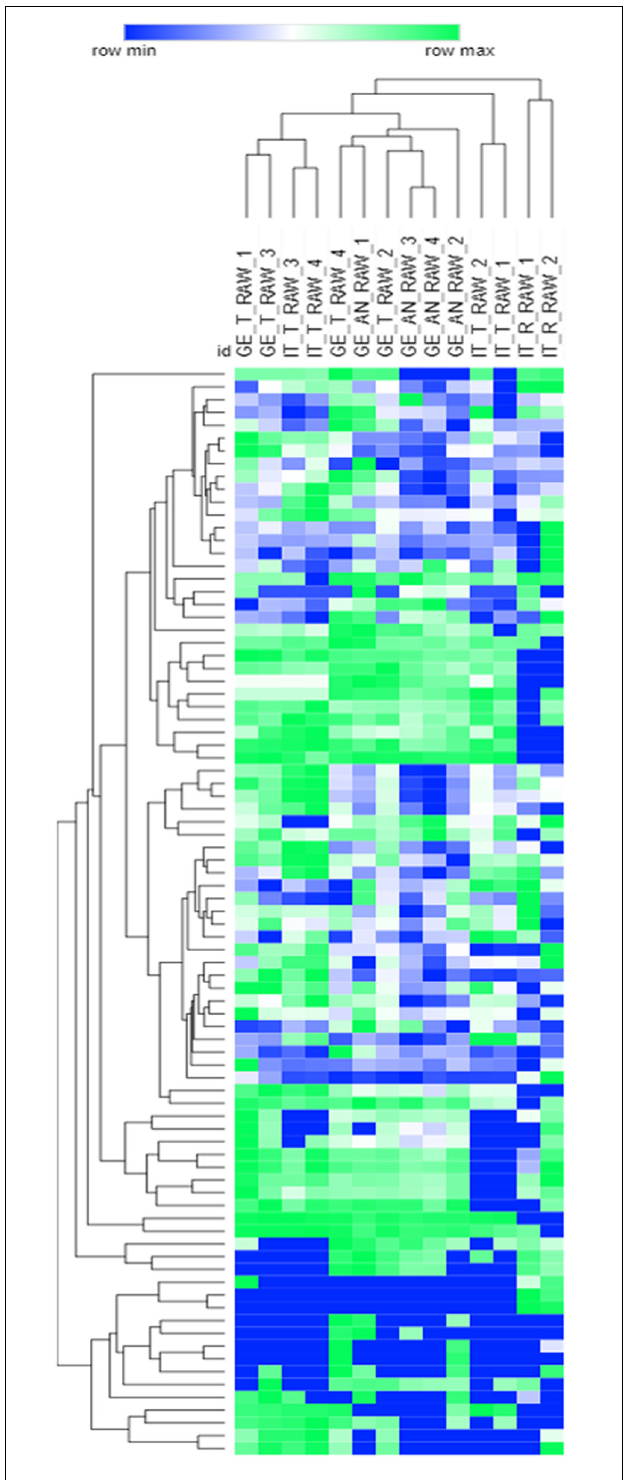
FIGURE 1 | Hierarchical clustering based on Euclidean distances of the raw Tonda Gentile Trilobata , Tonda Gentile Romana , and Anakliuri samples harvested in Italy and Georgia. The response data obtained by averaging batch replicates were log2 normalized; heat-map visualization is in a color scale from blue to green.